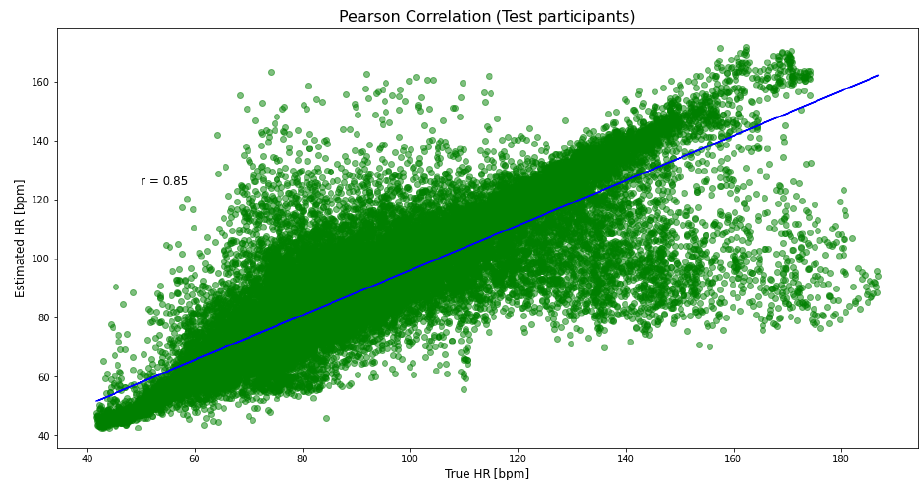
Figure 3. Pearson correlation between estimated and true HR